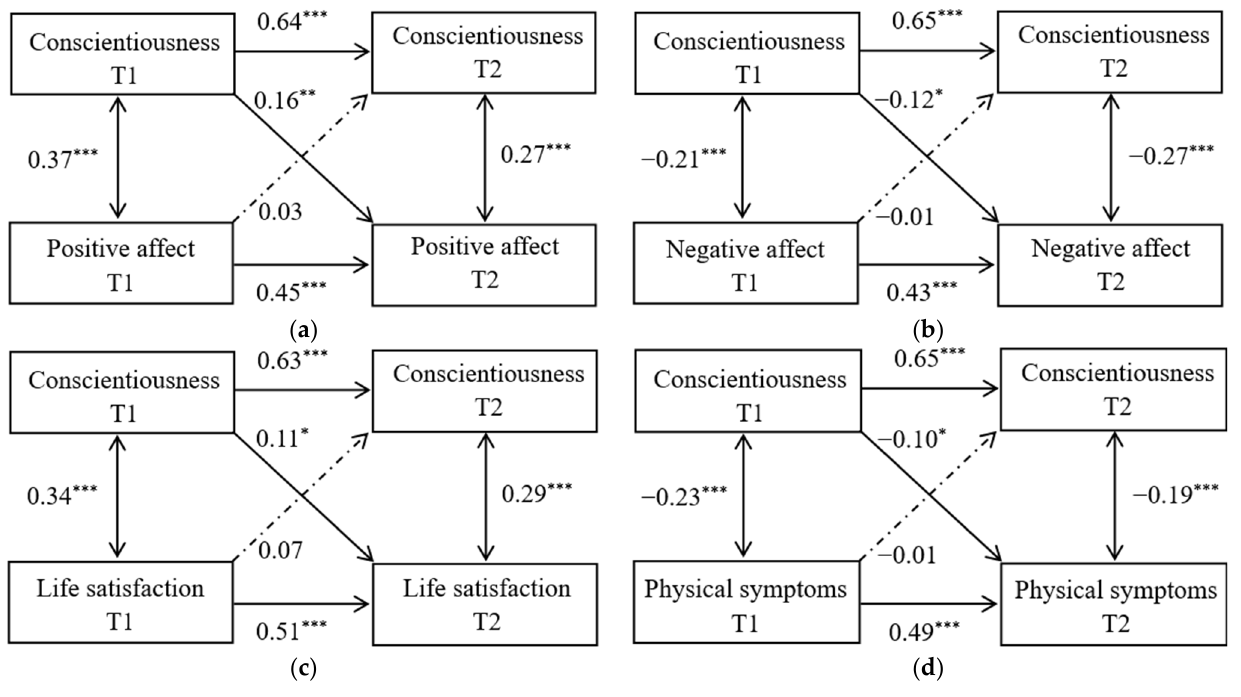
Figure 1. Multivariable cross-lagged panel models of ( a ) conscientiousness and positive affect, ( b ) conscientiousness and negative affect, ( c ) conscientiousness and life satisfaction, and ( d ) conscien- tiousness and physical symptoms. Note: The coefficients beside double arrows are partial correlations and the coefficients beside single arrows are standardized beta coefficients. Solid arrows represent significant paths and dotted arrows represent insignificant paths. The effects of demographic variables (gender, age, body-mass index [BMI], and socioeconomic status [SES]) on predicted variables were not shown for ease of presentation. T1: time 1, T2: time 2 (1 year later), * p < 0.05, ** p < 0.01, *** p < 0.001.